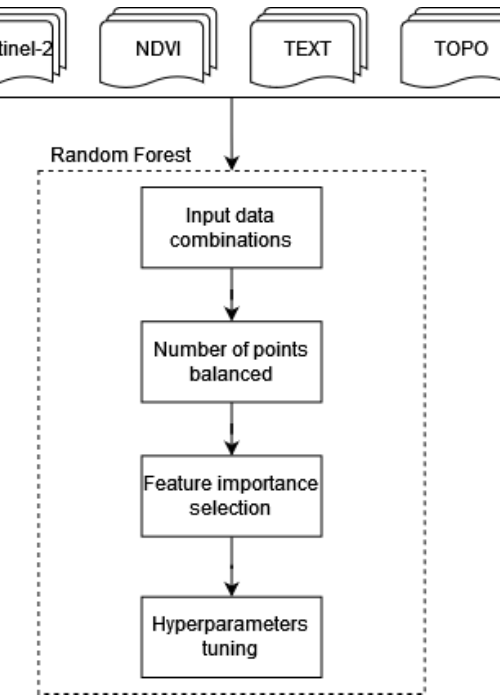
Figure 6. Classification